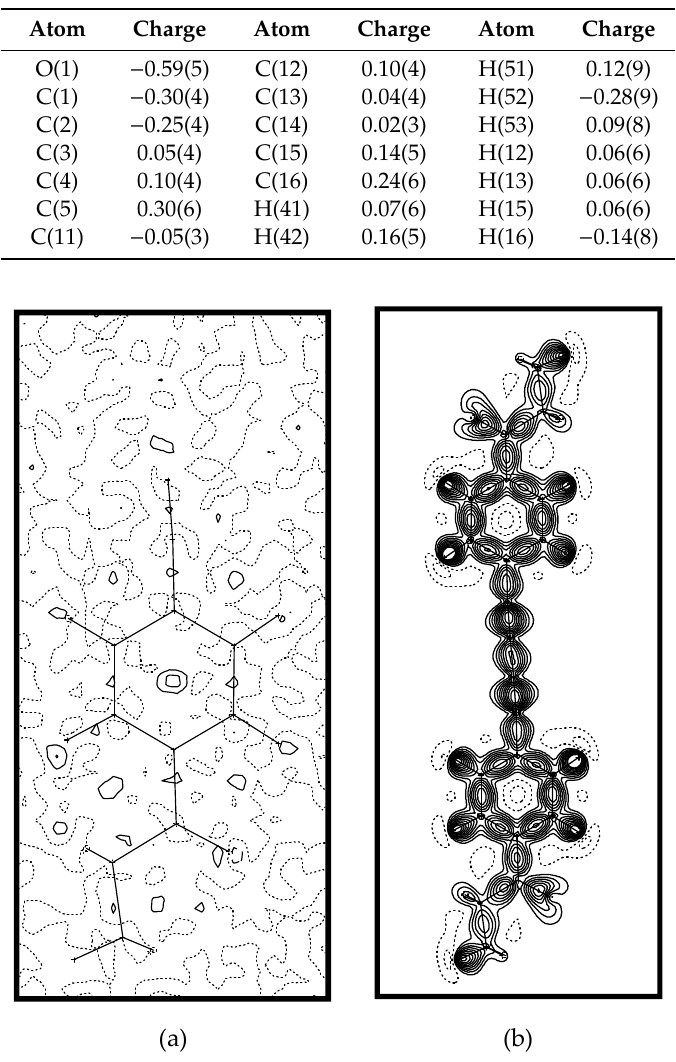
Table 2. Pseudoatom charges for 1 .